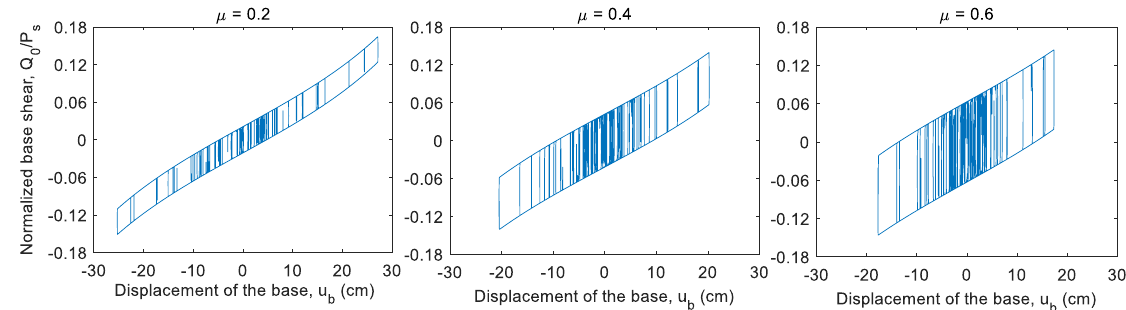
Figure 15. Hysteretic cycle of the isolation system of a rack with 6 levels and T I = 4 s. Figure 16 shows the ratio between the maximum axial load — tension — or minimum axial load — compression — on the isolators, and the initial tension of the cable ( T 0 ), consid- ering the seismic input acting in cross the aisles direction of the rack. While in Figure 17, the seismic input is considered to be acting in the longitudinal direction. If the quotient is greater than 1 there is lifting in the isolator, otherwise, the isolator is compressed and works stably.